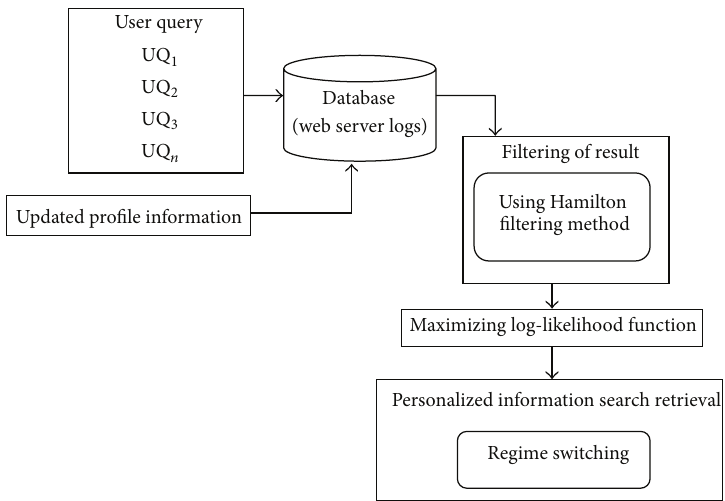
Figure 2: Architecture diagram of HFRS-UQP